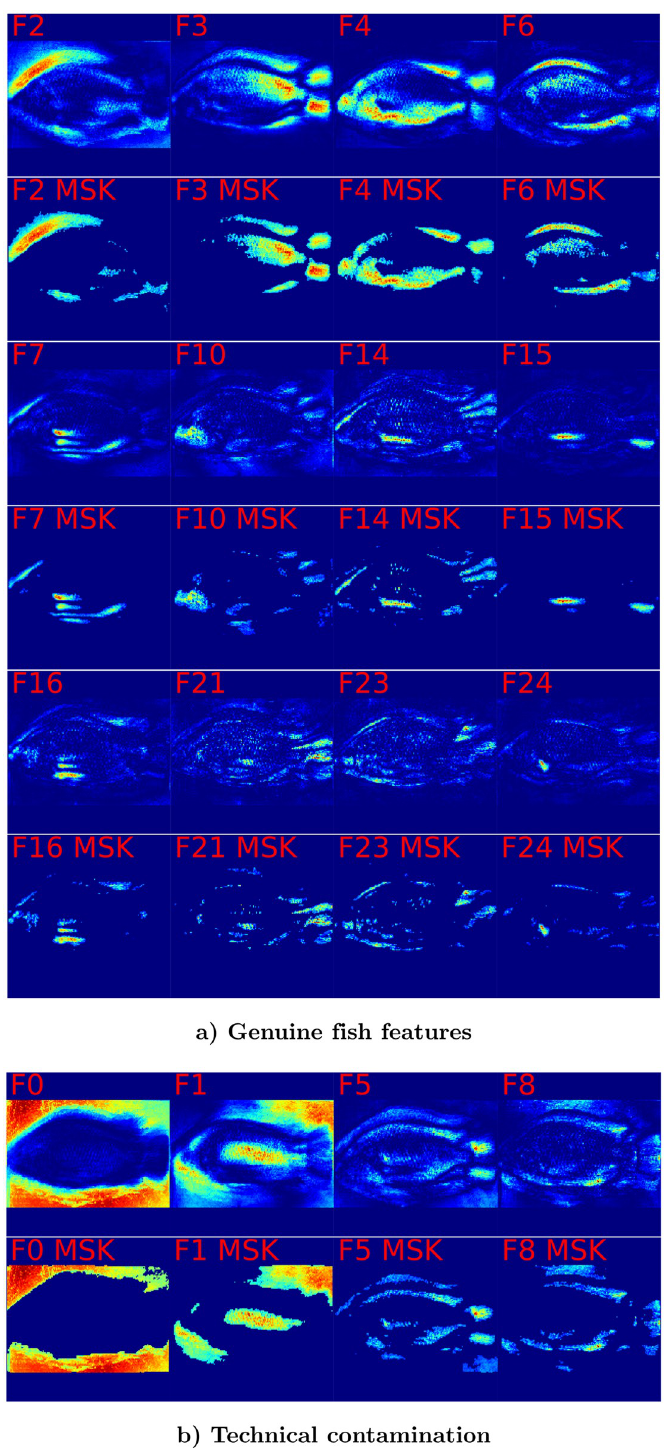
Fig 7. Variation of GP-LVM feature dimensions in image space. Image color is obtained by mapping variation of individual GP-LVM dimension to image coordinates. Low variation is represented as blue color. Intermediate variation has yellow color and red represents image regions which correspond to large variation in GP-LVM space. Odd rows display the entire saliency map. Even rows retain only highly relevant pixels which are by Eq (5) assessed as significant (p-value < 0.001). Fig 6a) illustrates 12 GP-LVM dimensions which represent genuine fish morphology